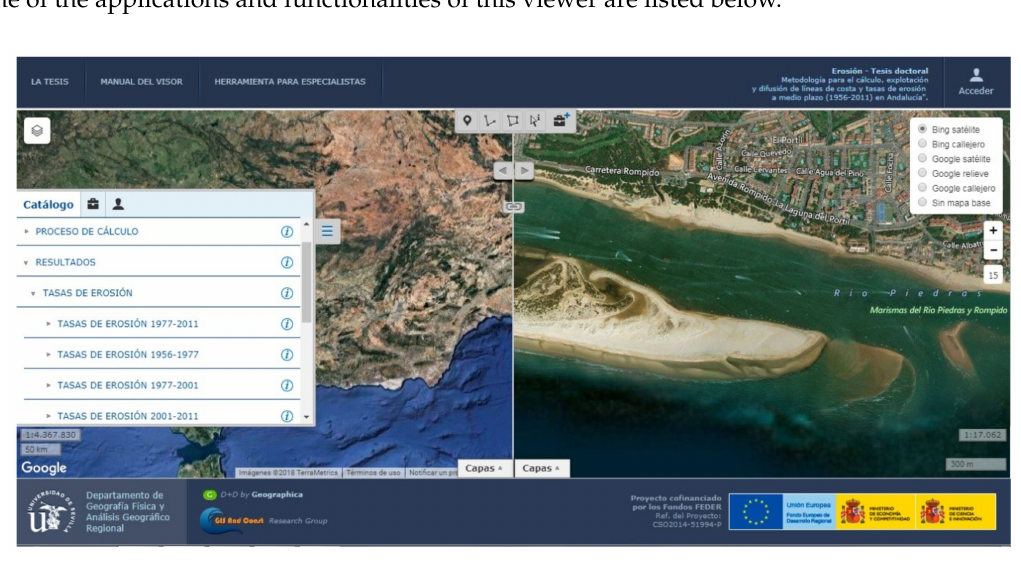
Figure 8. Interface of the web viewer designed to disseminate coastal information (https://www.